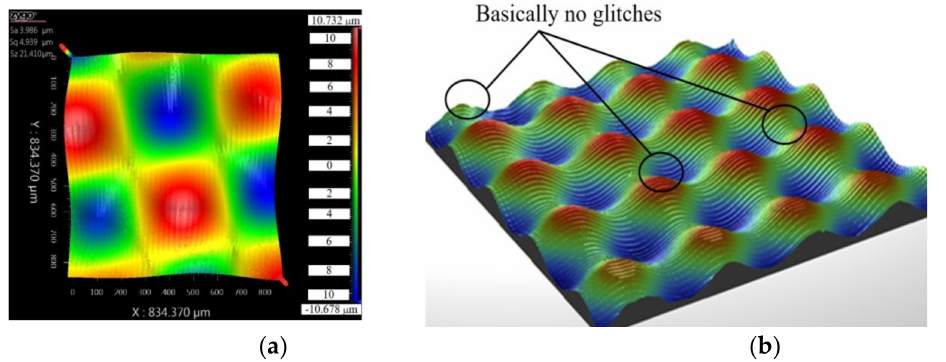
Figure 9. ( a ) Profile and ( b ) 3D contour of fabricated sinusoidal microstructures characterized by white light interferometer by jointly using the FTS system and rotary B -axis under the optimized machining parameters.